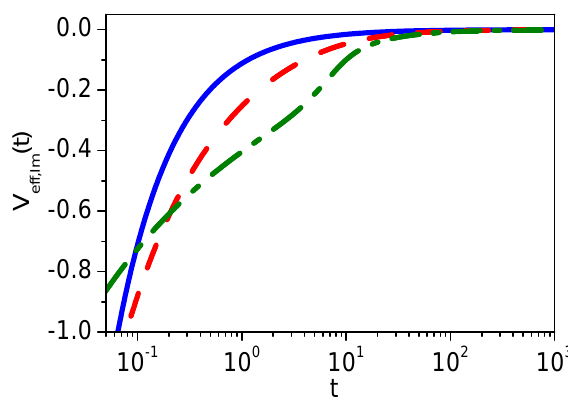
Figure 1. A graphical representation of the real and imaginary part of the effective potentiall (14) for λ = ¯ h = ω = 1, β = 1; α = 1/4 (blue solid line), α = 1/2 (red dashed line), α = 3/4 (green dot-dashed